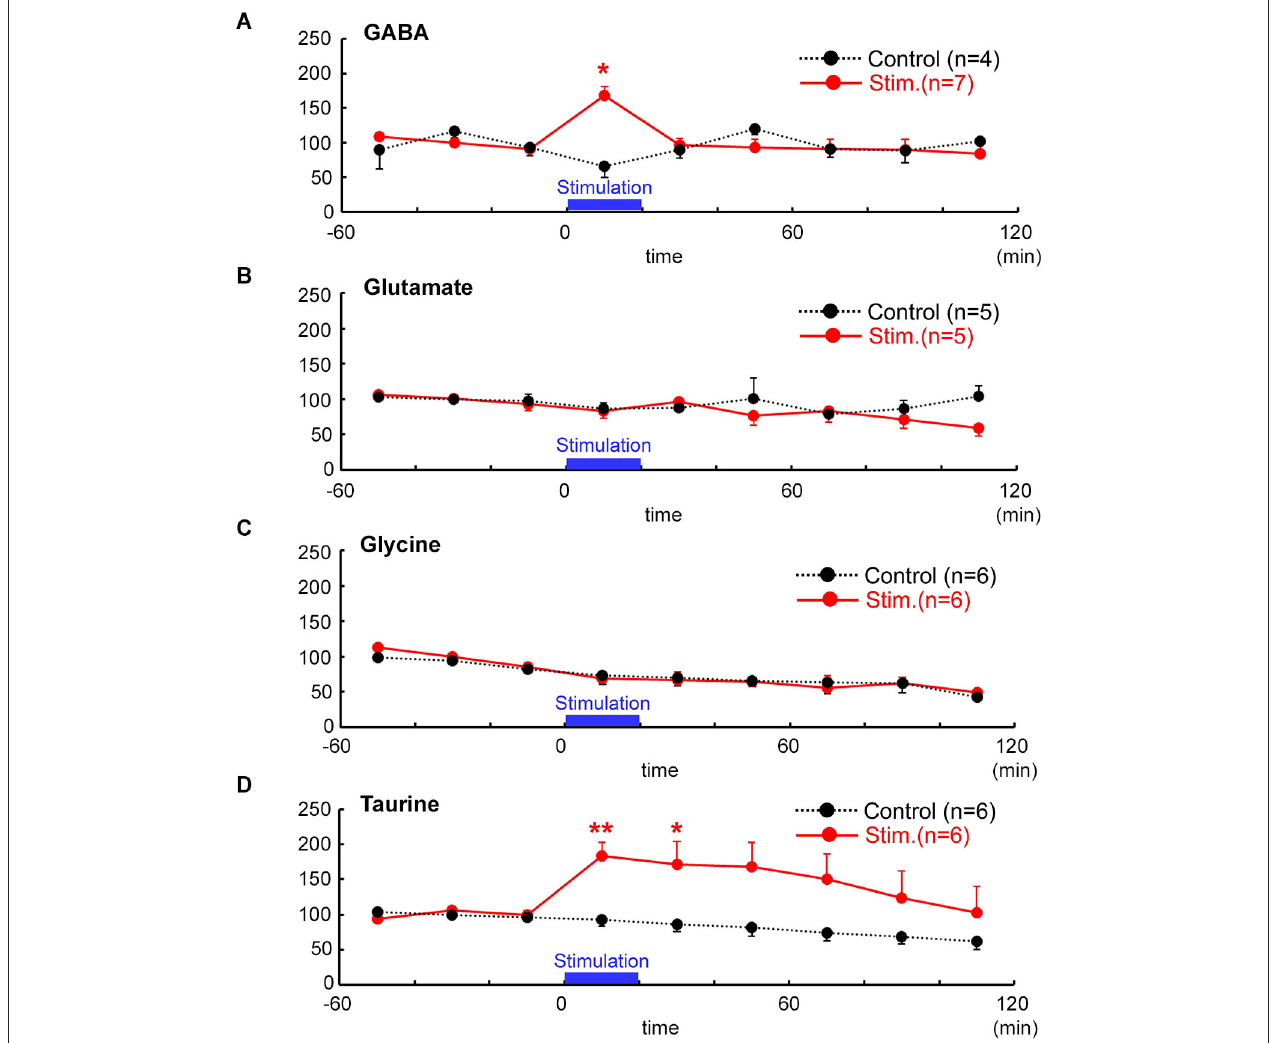
1 mA for 100 µ s was delivered at 1 Hz for 20 min, the periods of which are indicated by bars. Baseline values were defined as the average value 60 min immediately before stimulation. Note that taurine and GABA (with 1 mM nipecotic acid), but neither glycine nor glutamate, were significantly increased in response to the electrical stimulation in the MZ. ** P < 0.01, * P < 0.05 as compared with control (Mann–Whitney U